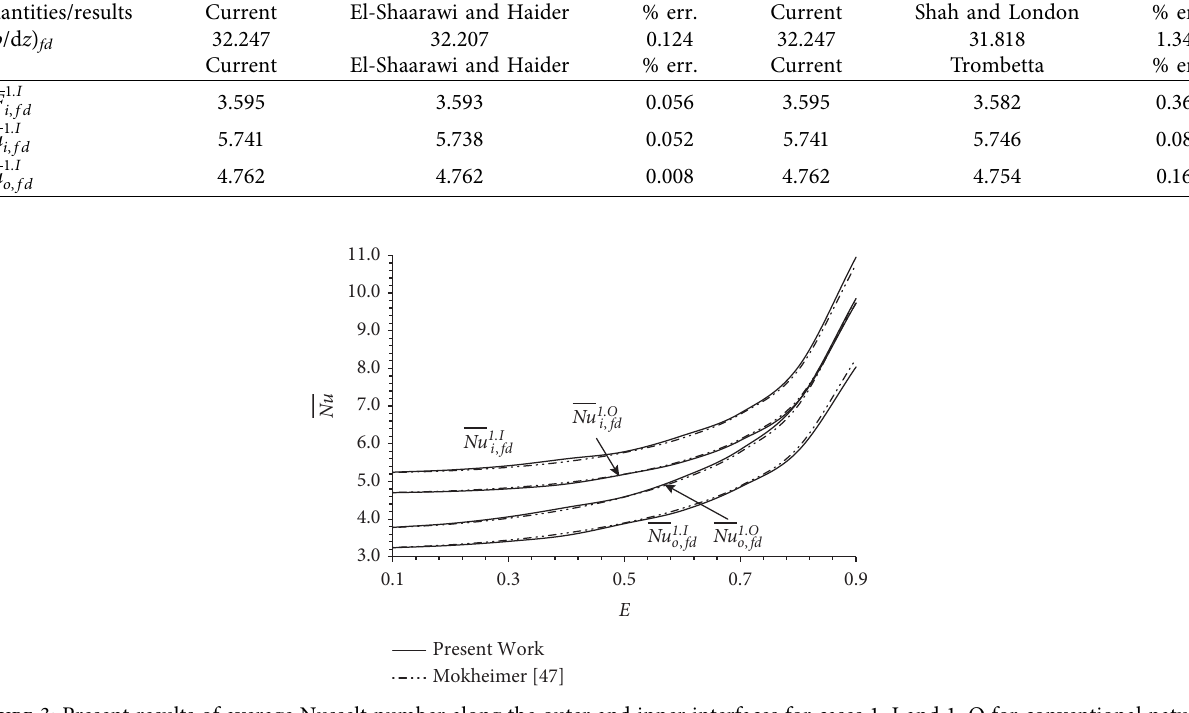
Figure 3: Present results of average Nusselt number along the outer and inner interfaces for cases 1. I and 1. O for conventional natural convection compared with those of Mokheimer [47], K r � 1000, χ 2 � 0.5, δ o � 0.002, δ i � 0.001, N � 20, M � 20, NSO � 25, NSI �